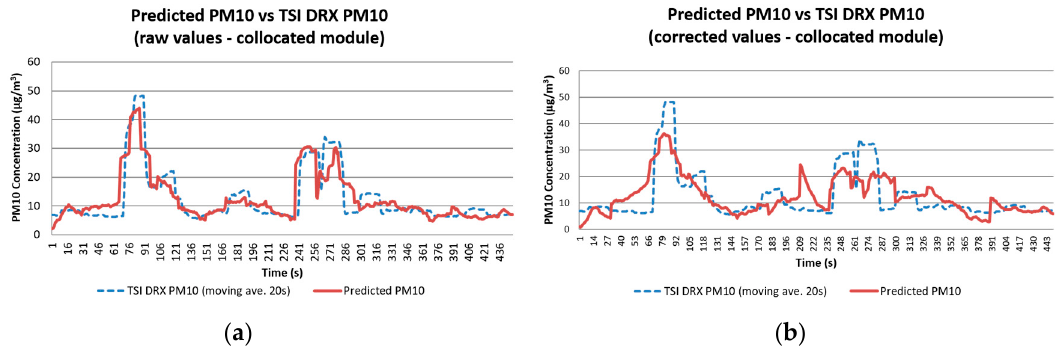
Figure 16. Comparison between PM 10 concentration readings obtained with the TSI DRX and the predicted values calculated using the models generated for Test 2 with ( a ) raw values, and ( b ) corrected data.